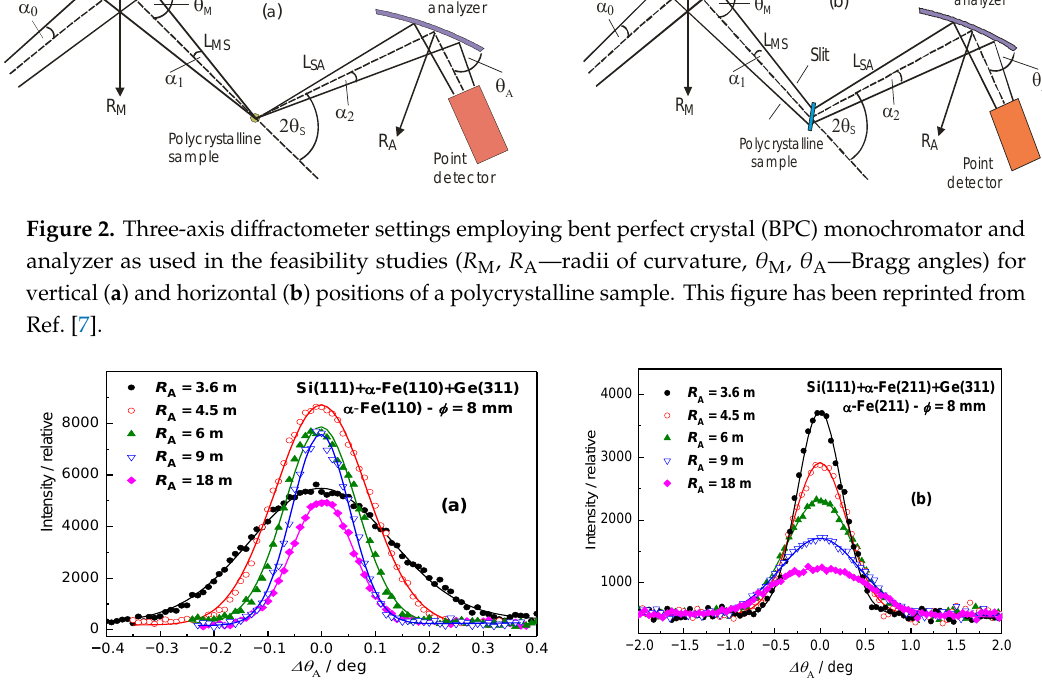
Figure 3. Analyzer rocking curves for different radii of curvature and for ( a ) α-Fe(110) and ( b ) α- Fe(211) reflections.